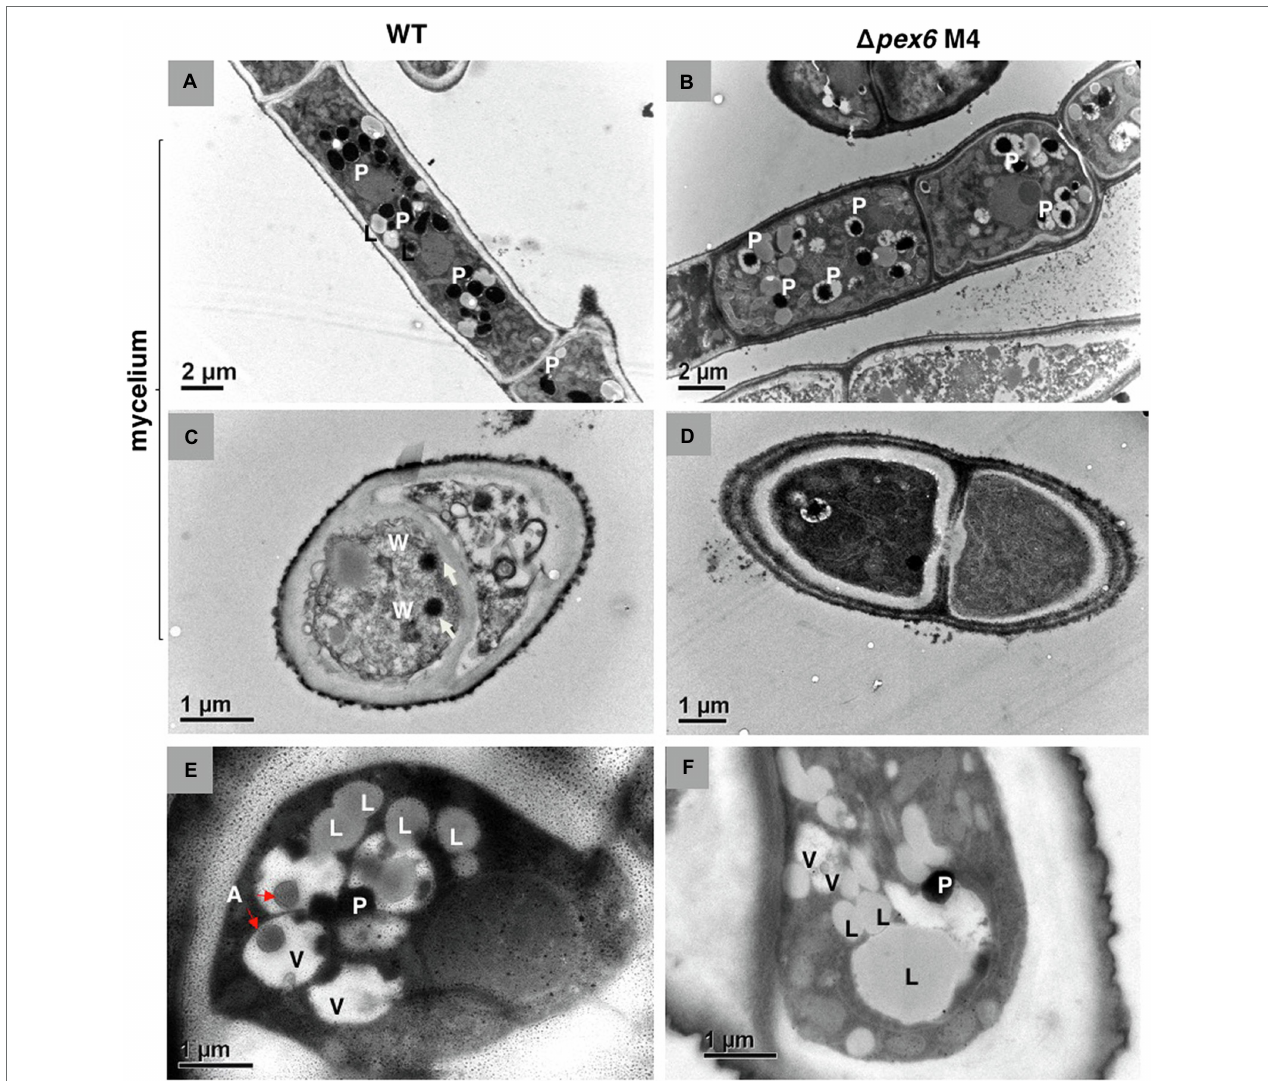
FIGURE 2 | Transmission electron microscopy of A. alternata hyphae (A–D) and conidia (E,F) . Longitudinal (A) and cross (C) sections of wild-type (WT) hyphae. Longitudinal (B) and cross (D) sections of Δ pex6 hyphae. P, peroxisome; L, lipid body; W, Woronin body; A, autophagic body; and V,